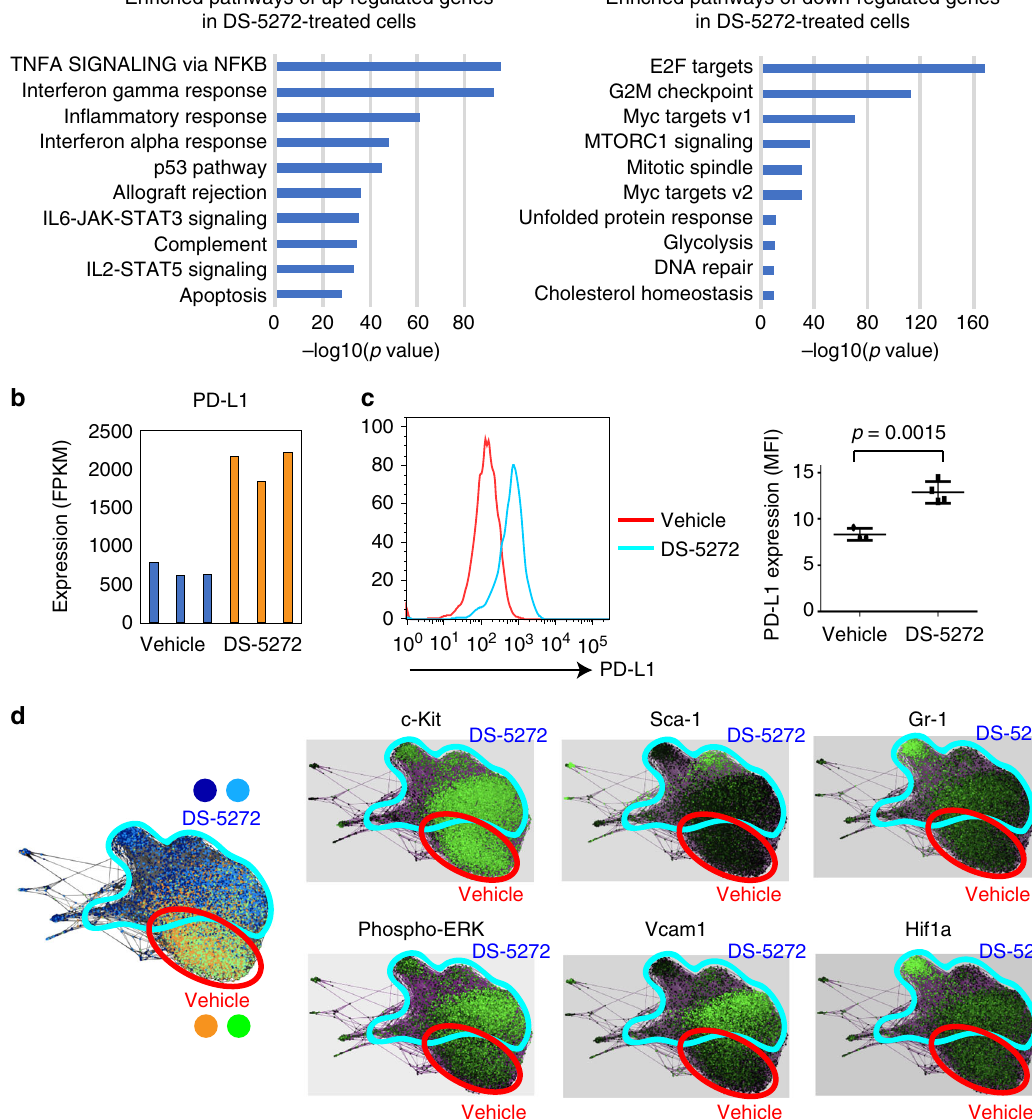
Fig. 3 DS-5272 treatment triggers an immune-in fl ammatory response in MLL-AF9 cells. a GSEA for up- and down-regulated genes in DS-5272-treated MLL-AF9 cells using the Hallmark collections of the GSEA MSigDB (http://software.broadinstitute.org/gsea/msigdb). The x axis shows the P value ( − log 10 ). b mRNA expression of PD-L1 in vehicle- or DS-5272-treated MLL-AF9 cells. c Cell surface expression of PD-L1 in vehicle- or DS-5272-treated MLL-AF9 cells. Representative FACS plots (left) and quanti fi cation of MFI of PD-L1 in MLL-AF9 cells (right). Data are shown as mean ± s.d. of four biologically independent experiments. Student t-test. d 25-dimensional analysis using SPRING (https://kleintools.hms.harvard.edu/tools/spring.html) of bone marrow cells from MLL-AF9 leukemia mice treated with vehicle and DS-5272 for 24 h ( n = 2/condition). Differences in the location of cells within the SPRING map resulted from changes in protein expression. The regions enclosed by the red and blue curves represent the cells treated with vehicle or DS-5272, respectively. At right, surface (c-Kit, Gr-1, Vcam1) and intracellular signaling pathway (phospho-ERK) markers in vehicle- and DS-5272-treated MLL-AF9 leukemia cells are